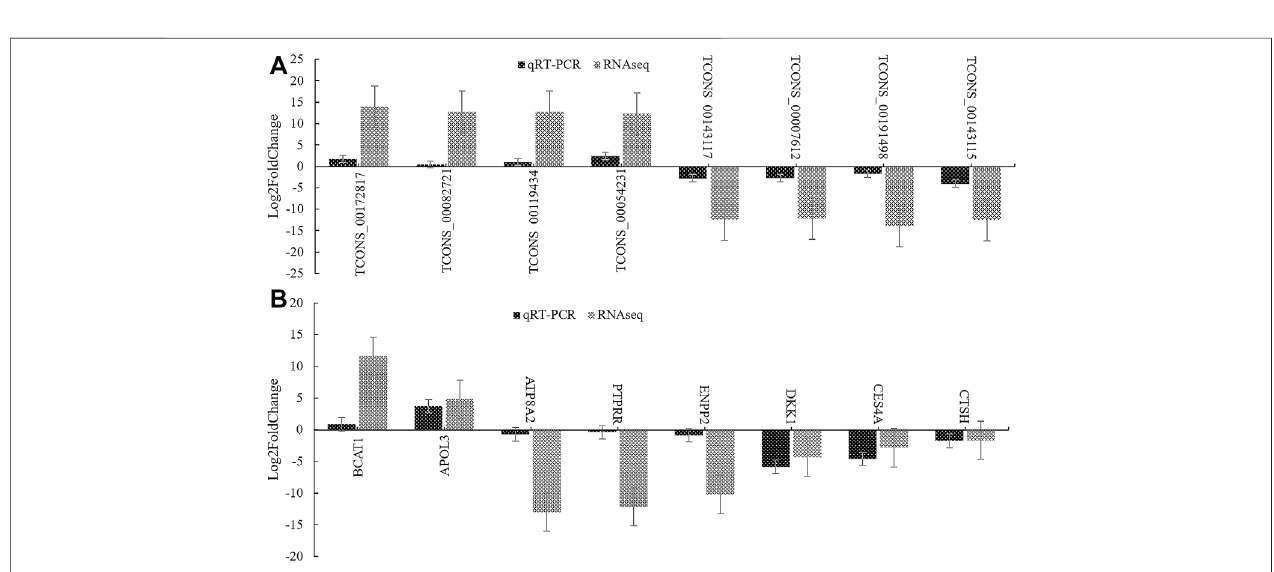
FIGURE 11 | qRT-PCR veri fi cation of DEGs and DELs. (A) : The veri fi cation result of DELs. (B) : The veri fi cation result of DEGs. log2FoldChange is logarithm of fold change with a base of 2.